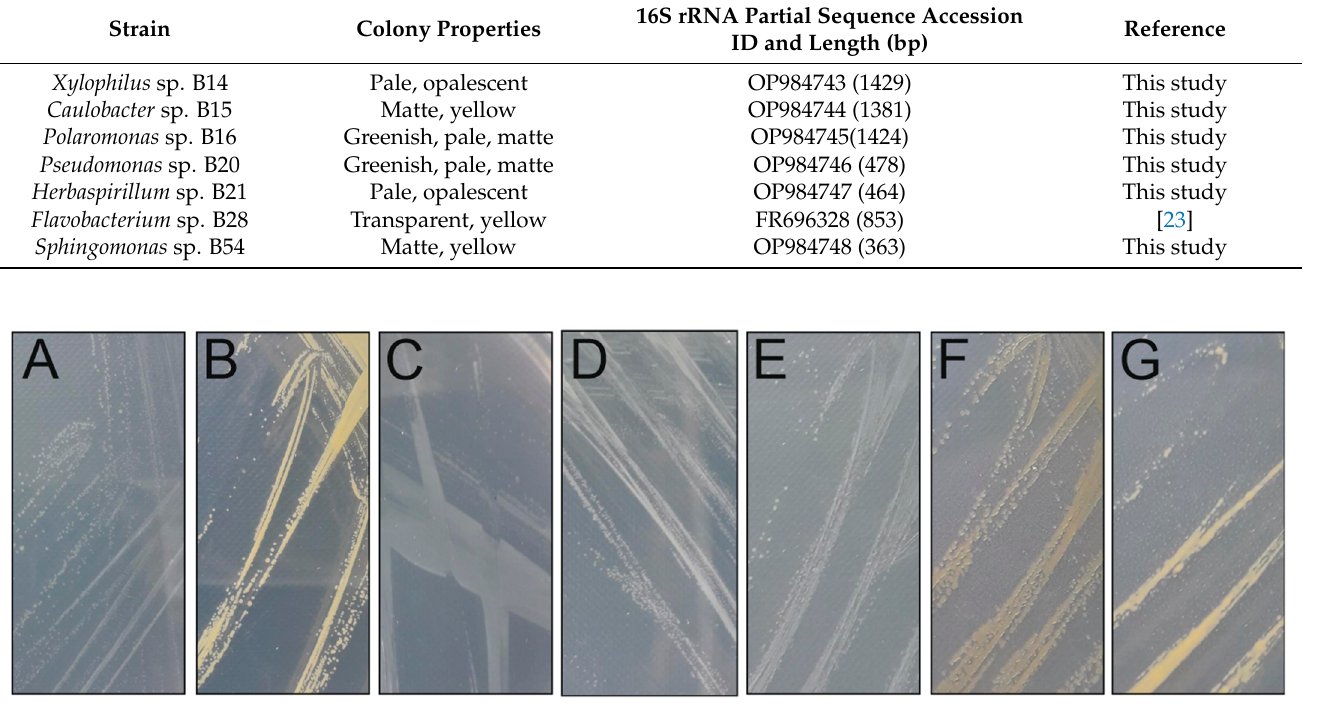
Table 1. Properties of the bacterial strains used in the study.